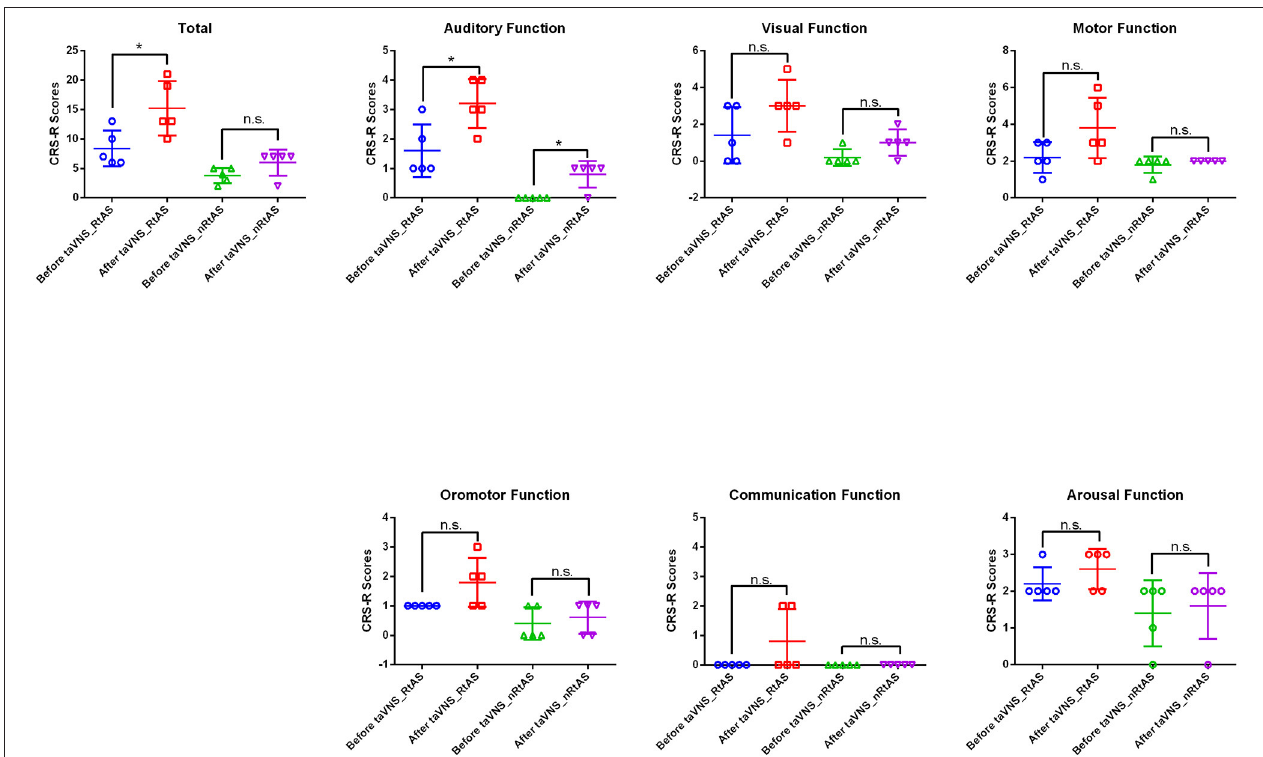
FIGURE 1 | Patients’ CRS-R total and subitems scores before and after taVNS. * P < 0.05, before taVNS vs. after taVNS; n.s., not significant; P > 0.05; before taVNS vs. after